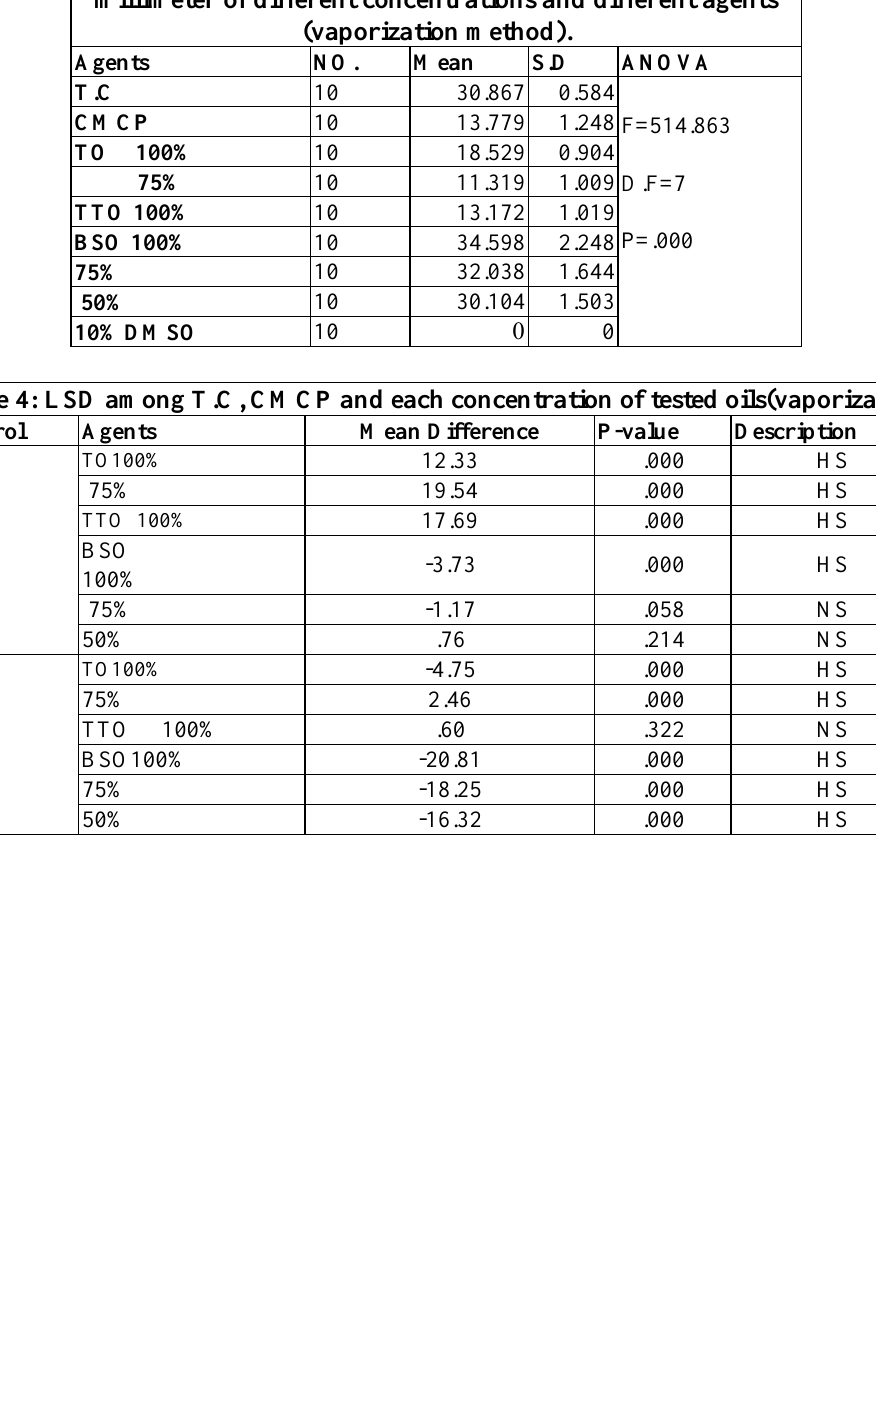
Table 3: ANOVA, Mean, S.D of E.faecalis inhibition zone in millimeter of different concentrations and different agents (vaporization method). Agents NO. Mean